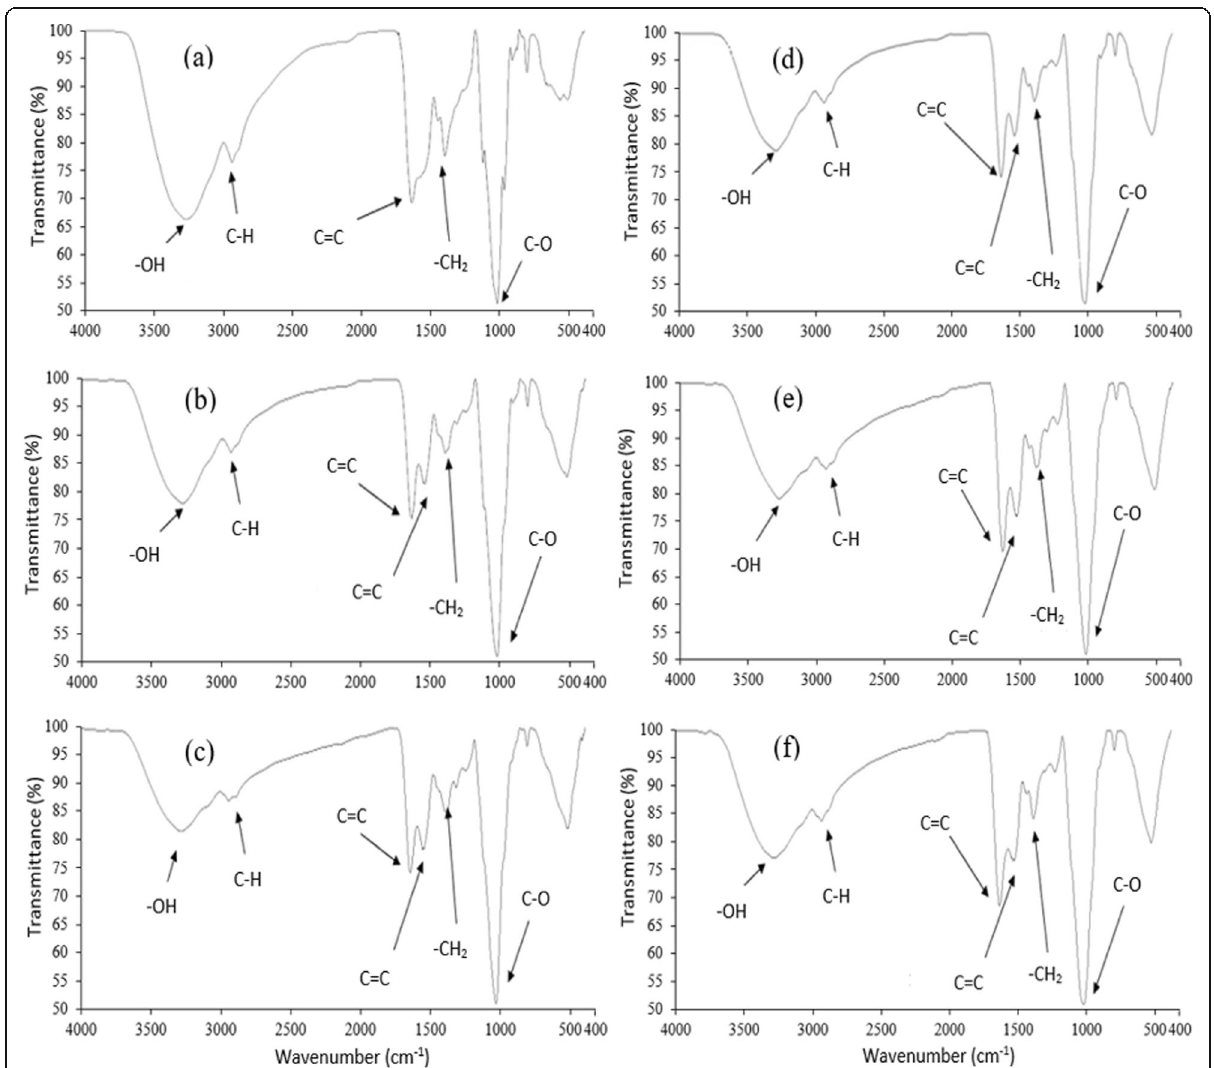
Fig. 3 FTIR spectrum for EPS derived from B. cereus cultivated under Zn metal stress at different concentrations ( a ) control ( b ) 10 mg L − 1 ( c ) 20